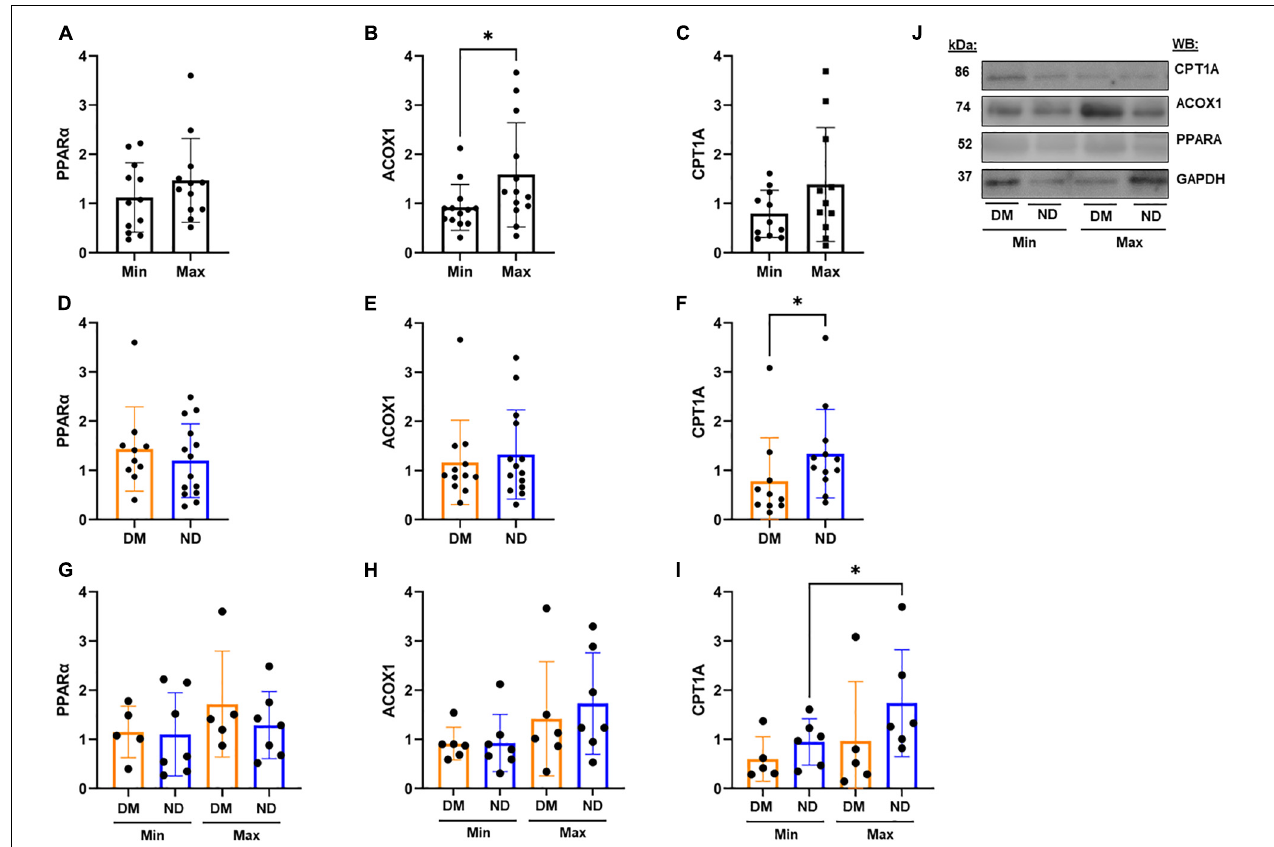
FIGURE 6 | Western Blot Analysis from Lower Extremity Segments in Varying Disease and Diabetic Status. (A–C) In lower extremity arterial segments, we found no difference in relative PPAR α ( n = 12) or CPT1A ( n = 11) abundance between Min or Max segments. However, we found Min segments demonstrate a decrease in ACOX1 compared to Max samples ( p < 0.05, n = 13). (D–F) We found no difference in relative PPAR α abundance between patients with and without diabetes. ACOX1 demonstrated decreased expression in patients with diabetes ( n = 13) compared to patients without diabetes ( n = 13), and CPT1A similarly showed a decrease in expression in patients with diabetes ( n = 10) compared to patients without ( n = 12). (G–I) Subdividing tissue segments into both disease and diabetic status showed no significant variability in PPAR α or ACOX1 expression. However, CPT1A expression was decreased in Min samples compared to Max samples in patients without diabetes ( n = 6). (J) Representative Western Blots from analysis. Samples were normalized to GAPDH content. DM, Diabetic. ND, Non-diabetic. Min, Minimally diseased. Max, Maximally diseased. Data are presented as Mean ± SD, and each point represents one patient sample. ∗ p <